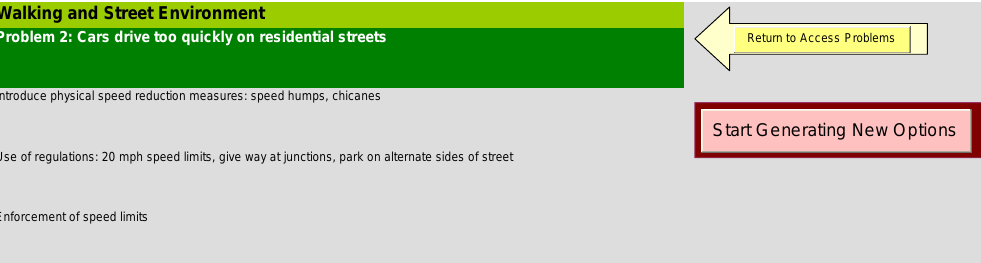
Figure 10. Examples of suggested, ‘inside-the-box’ solutions Source: Extracted from Jones and Paskins (2008), Figure